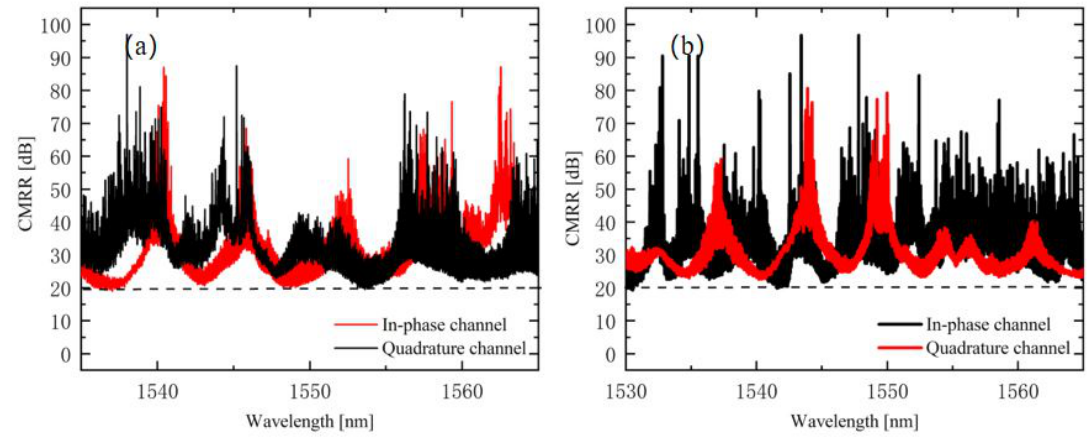
Figure 14. The calculated CMRRs of ( a ) input port 1 and ( b ) input port 3.